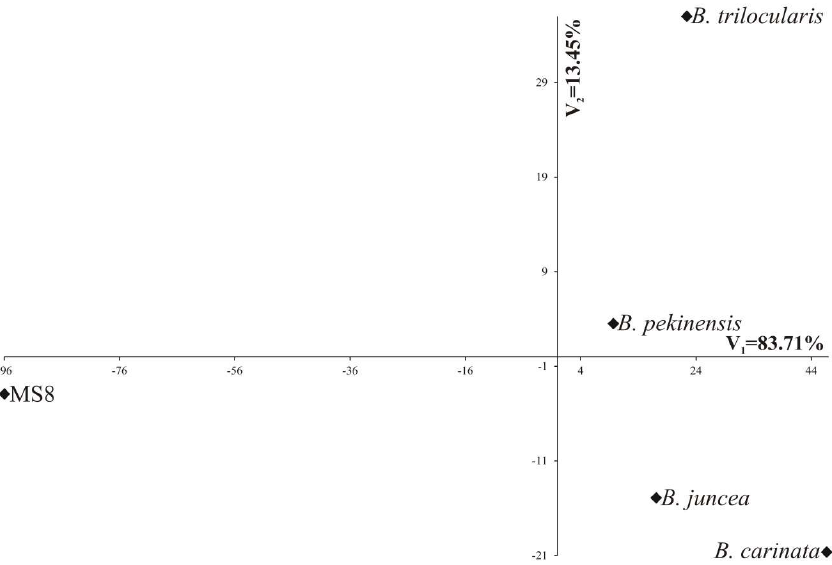
Figure 2. Location of Brassica parental forms in the system of the first two canonical variables. Table 4. Mahalanobis distances for parental